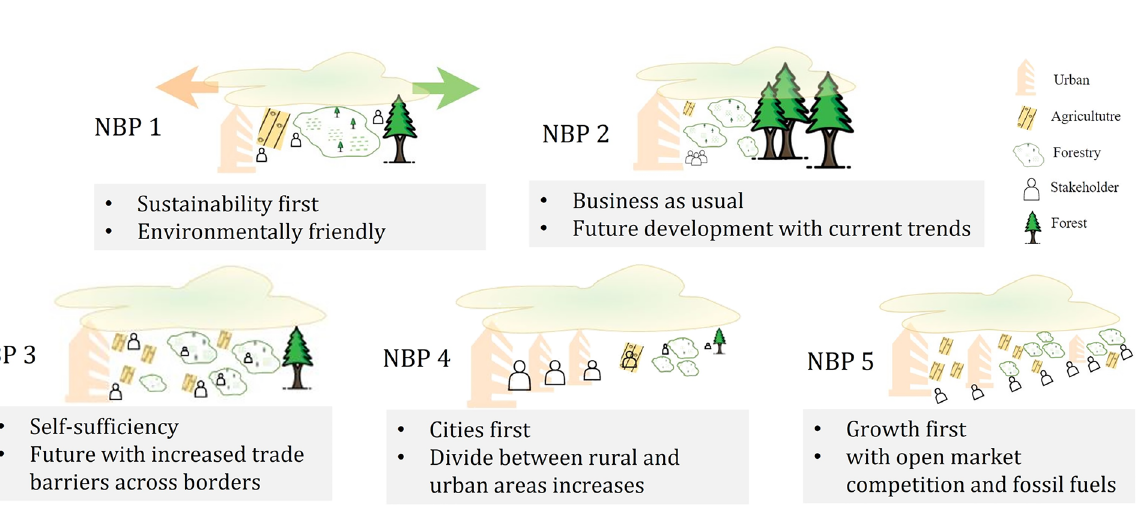
Figure 1. A conceptual diagram of each Nordic Bioeconomy Pathway (NBP) based on the detailed descriptions of NBPs 30